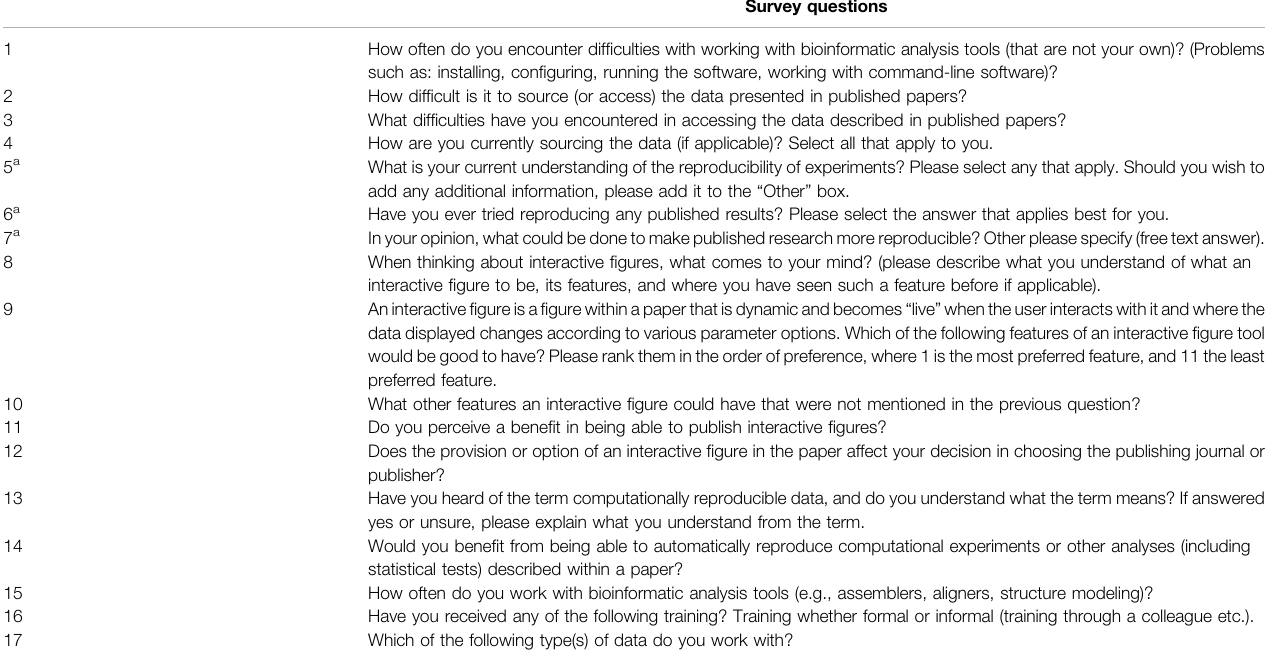
TABLE 1 | Questions used to survey the knowledge of respondents about research